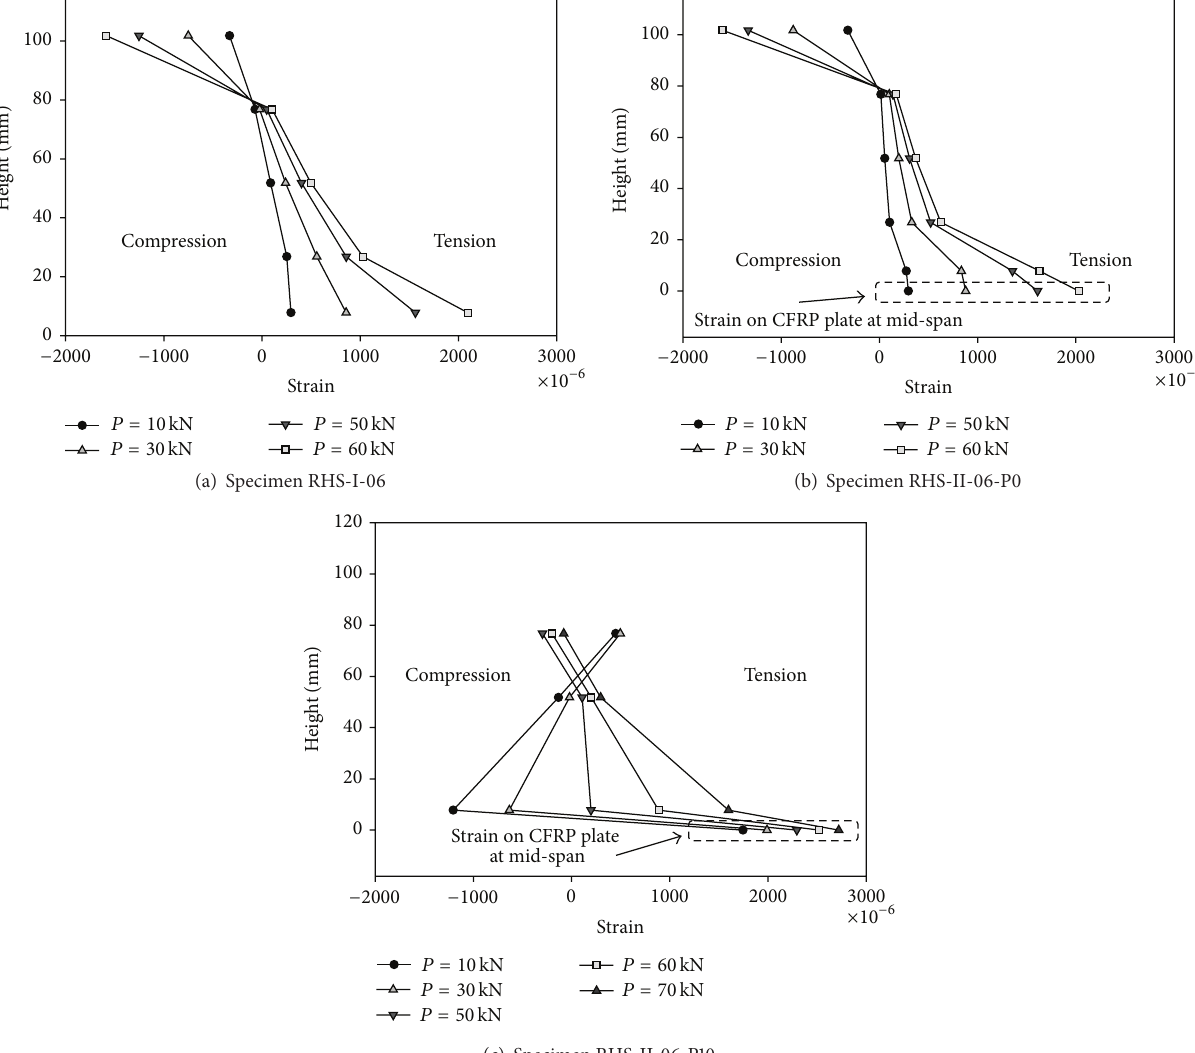
Figure 8: Comparison of strain distribution on cross